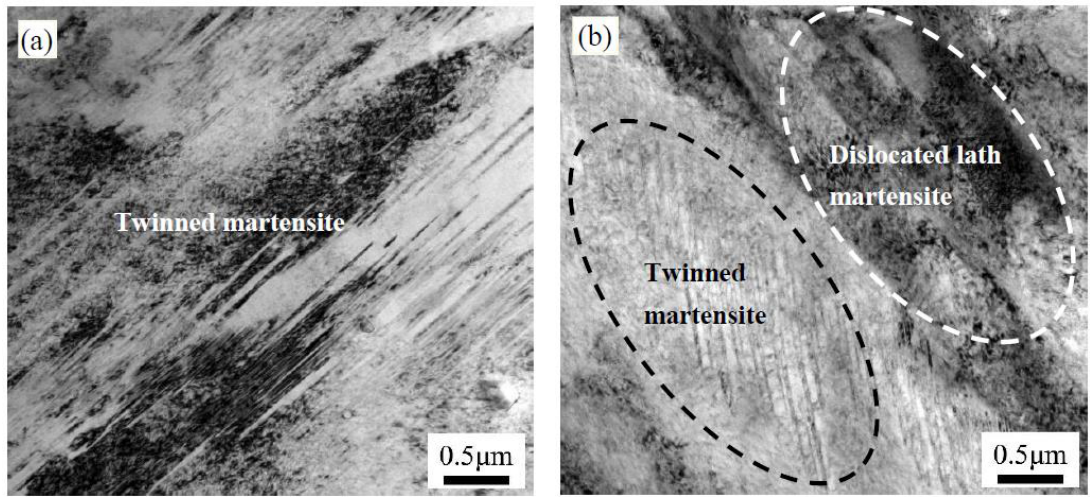
Figure 10. TEM images of the morphology of the martensite in the carburized layer: ( a ) after quenching; and ( b ) after the low-temperature tempering.